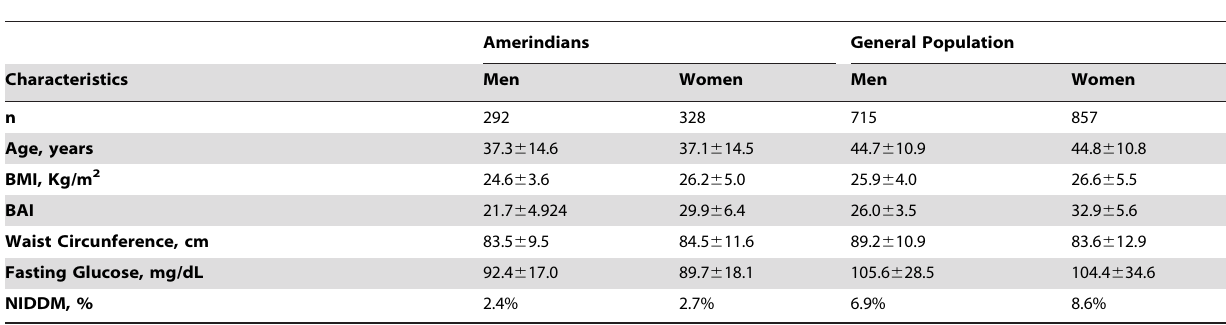
Table 1. Characteristics of subjects in the Amerindian and General